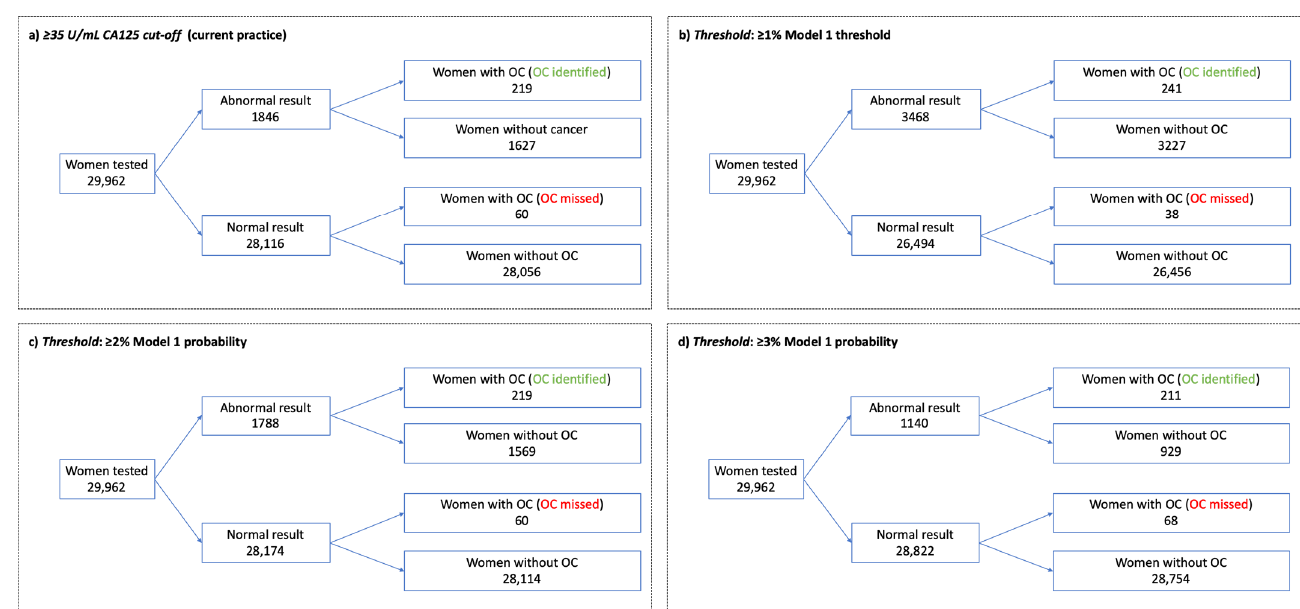
Figure 2. Implications of applying CA125 and model thresholds to the study